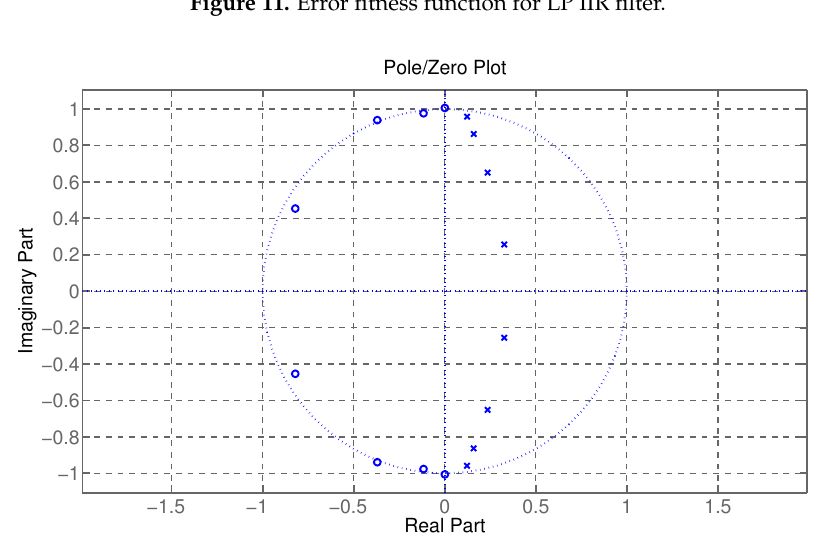
Figure 12. Pole-zero plot of LP IIR